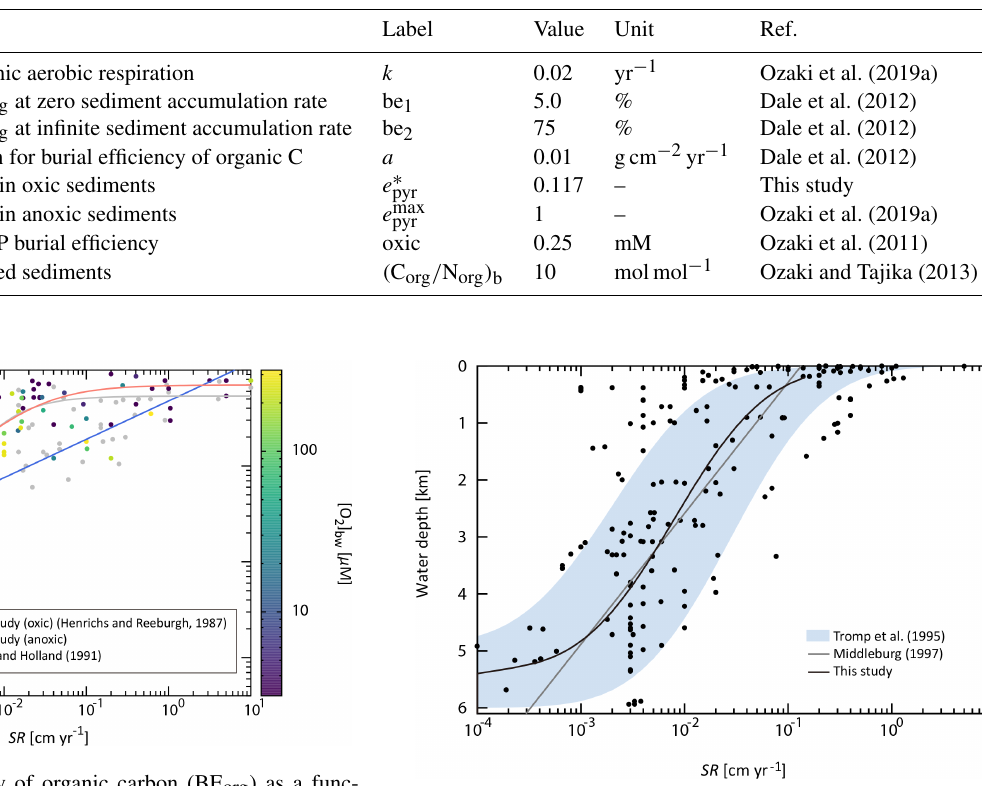
Figure 7. Sedimentation rate as a function of water depth. Data (black dots) were compiled from literature survey (Colman and Hol- land, 2000; Baturin, 2007; Betts and Holland, 1991; Tromp et al., 1995; Cha et al., 2005; Reimers et al., 1992). Black line represents the relationship assumed in the CANOPS-GRB model. Previously estimated empirical relationships (Middelburg et al., 1997; Tromp et al., 1995) are also